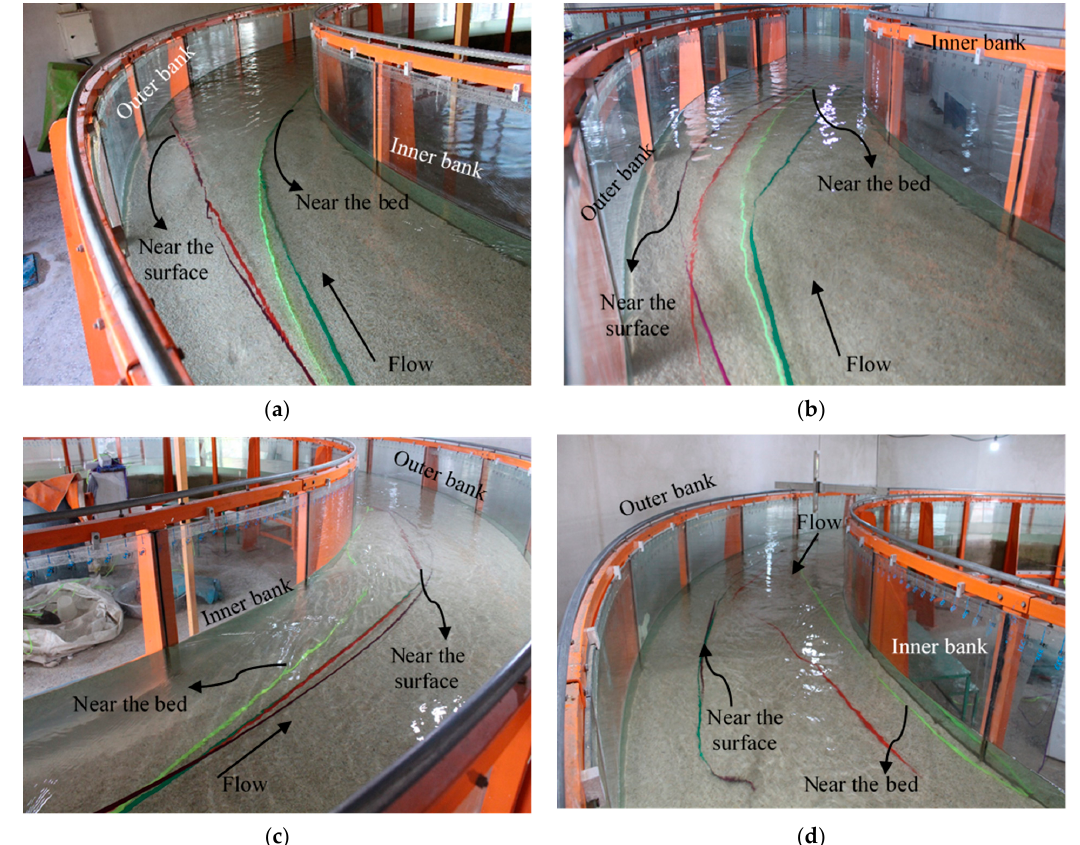
Figure 9. Instances of the qualitative flow behavior at the upstream and downstream bends of the meandering channel for U/Uc = 0.98 at ( a ) the upstream bend inlet, ( b ) the upstream bend outlet, ( c ) the downstream bend inlet, and ( d ) the downstream bend outlet.